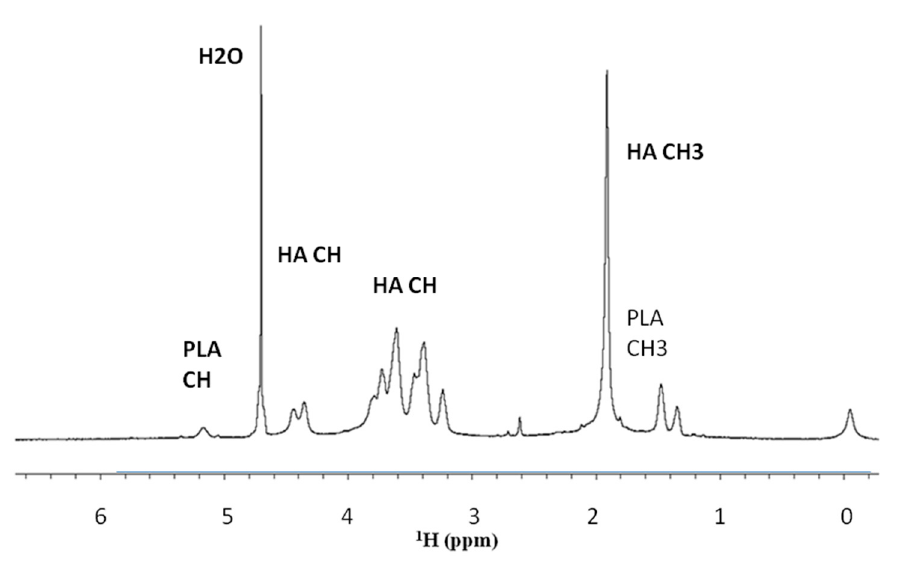
Figure 2. NMR spectrum for HA-PLA DAC ® sterilized HA sodium salt–PLA at a concentration of 7.5 mg/mL in D 2 O-PBS obtained as reported in Materials and Methods.